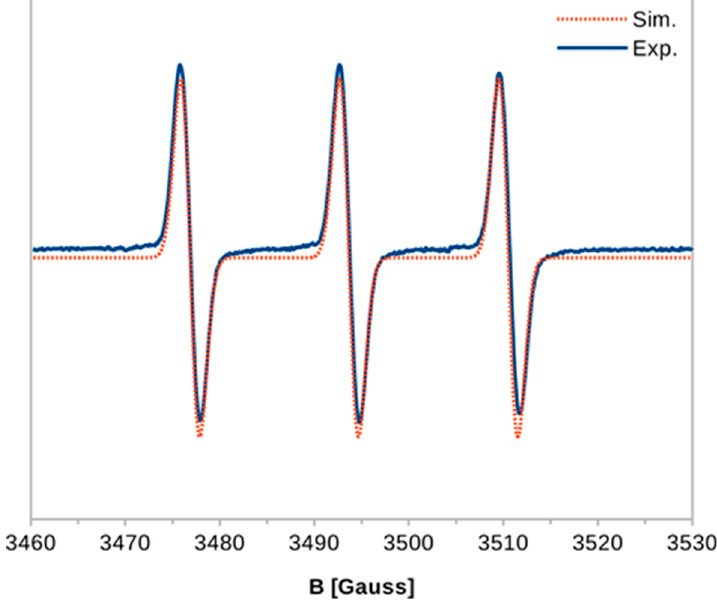
= 2.00543 and a 14 N) iso (